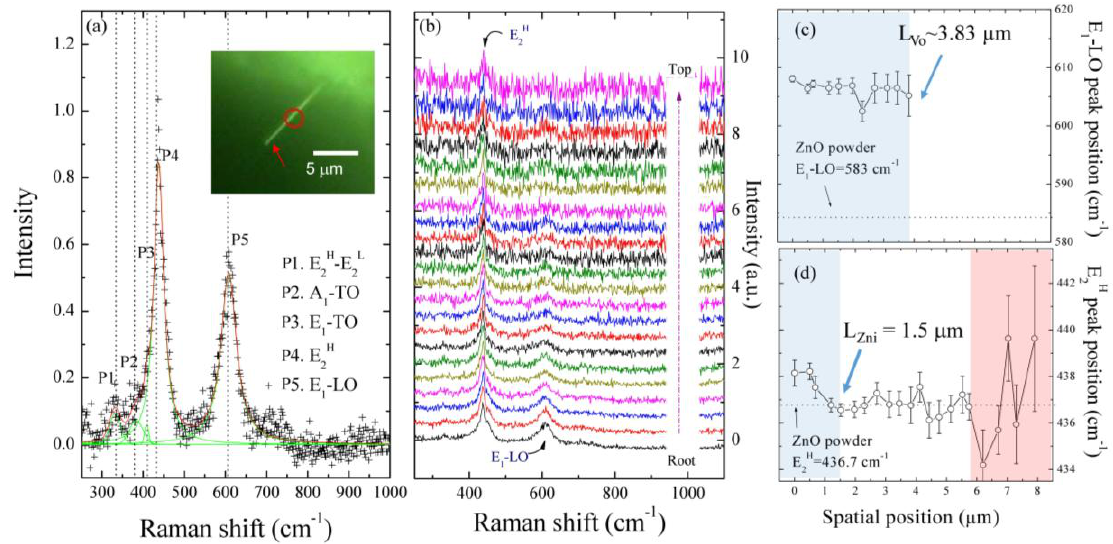
Figure 3. Raman spectra taken ( a ) from the bottom and ( b ) along the growth direction of a single ZnO NW. The inset to ( a ) shows the corresponding optical image of the ZnO NW; ( c , d ) peak position of the E 1 -LO and E 2H modes along the growth direction of the ZnO NW, respectively. Table 1. Summary of the fitting parameters of each phonon vibration mode along the growth direction of a single ZnO NW.